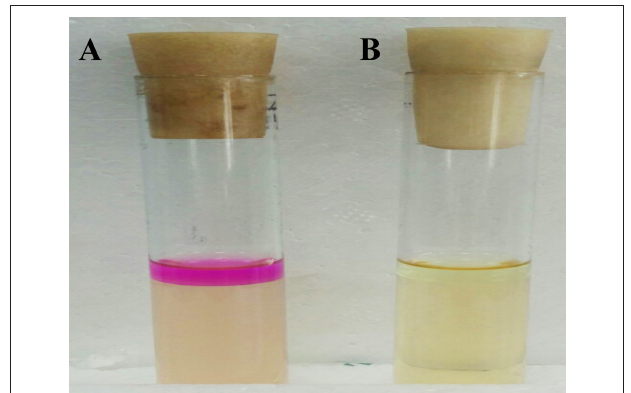
FIGURE 5 | Detection result of the indole produced by Enterococcus durans KLDS6.0930. (A) The positive control strain, Escherichia coli ATCC 25922 , and (B) E. durans KLDS6.0930.